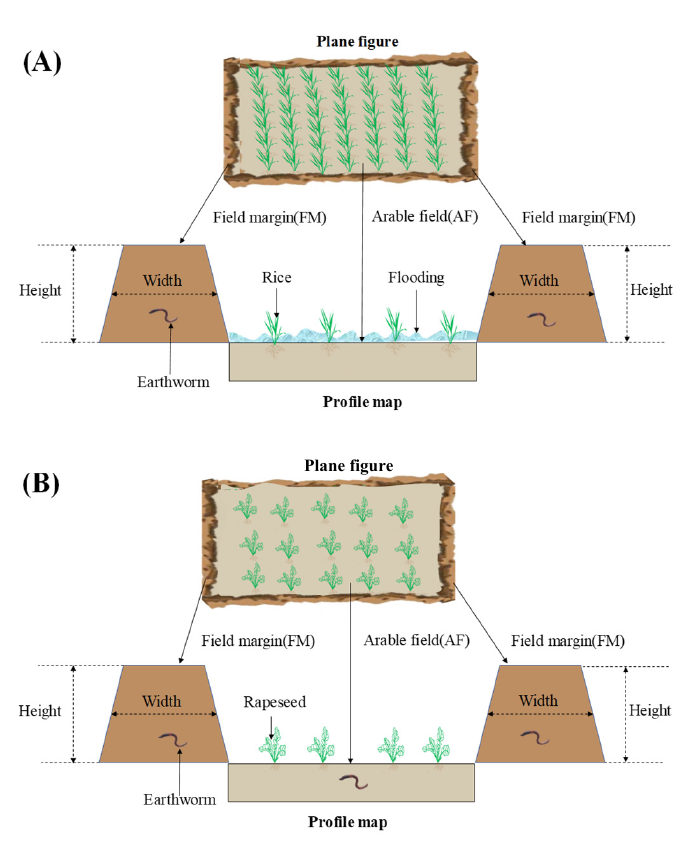
Figure 3. The plane figure and profile map of plot. ( A ): Rice growth period; ( B ): Rape growth period.